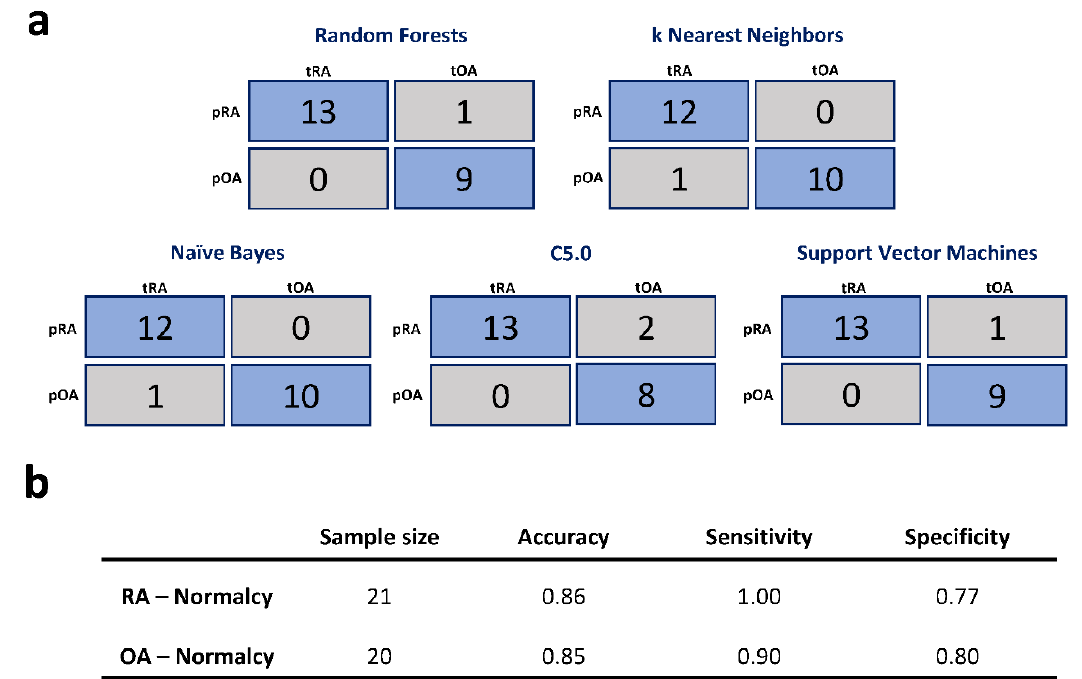
Figure 5. Summarization of the classification analyses. ( a ) Confusion matrices of the five classifiers on the test set of RA versus OA. ( b ) Prediction performances on the test sets of RA versus normalcy and OA versus normalcy. RA: Rheumatoid arthritis; OA: osteoarthritis.